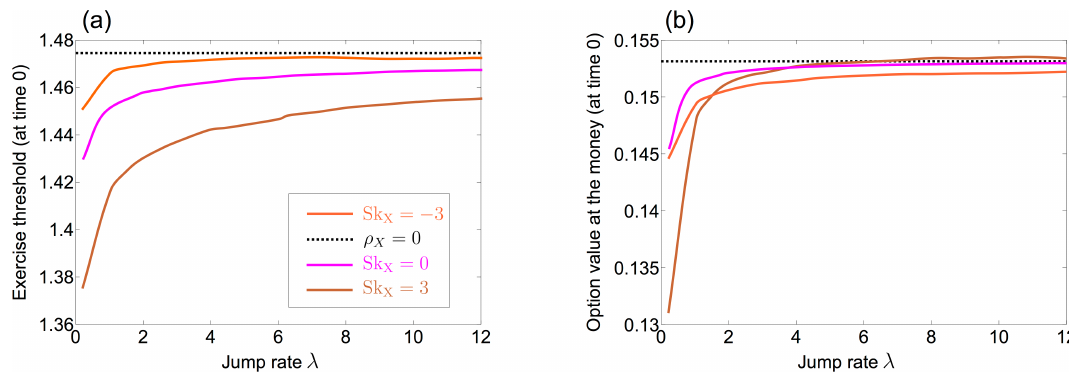
Figure 7. Plots of exercise threshold ( a ) and option value ( b ) at time t = 0, vs. jump rate λ , for different values of skewness ( − 3, 0, 3). Other parameters are given in the text. In particular, ρ X = 0.6. The comparison level when ρ X = 0 is indicated using a black dotted